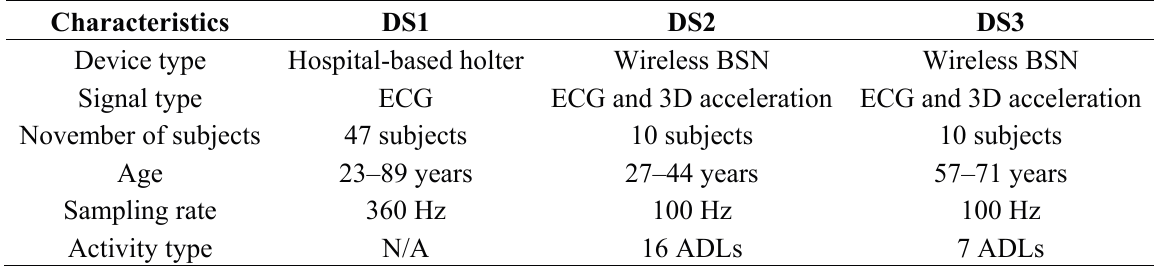
Table 2. A summary of dataset descriptions.